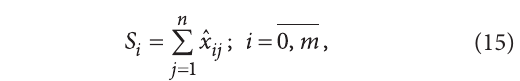
Fig. 6. Comparison of foundation instalment alternatives performance